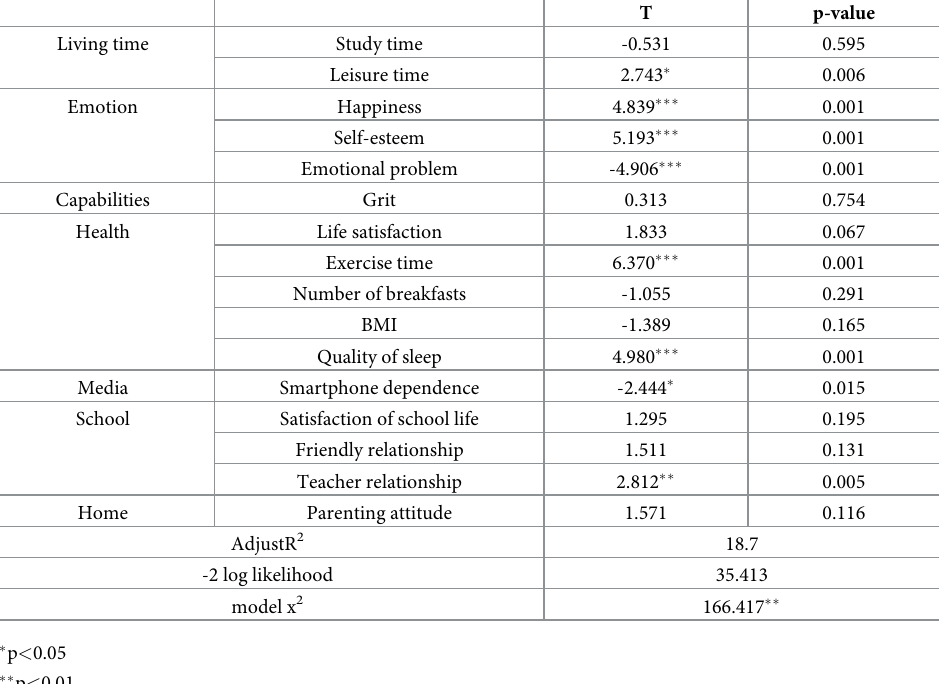
Table 3. Factors affecting subjective health conditions of fourth graders in elementary